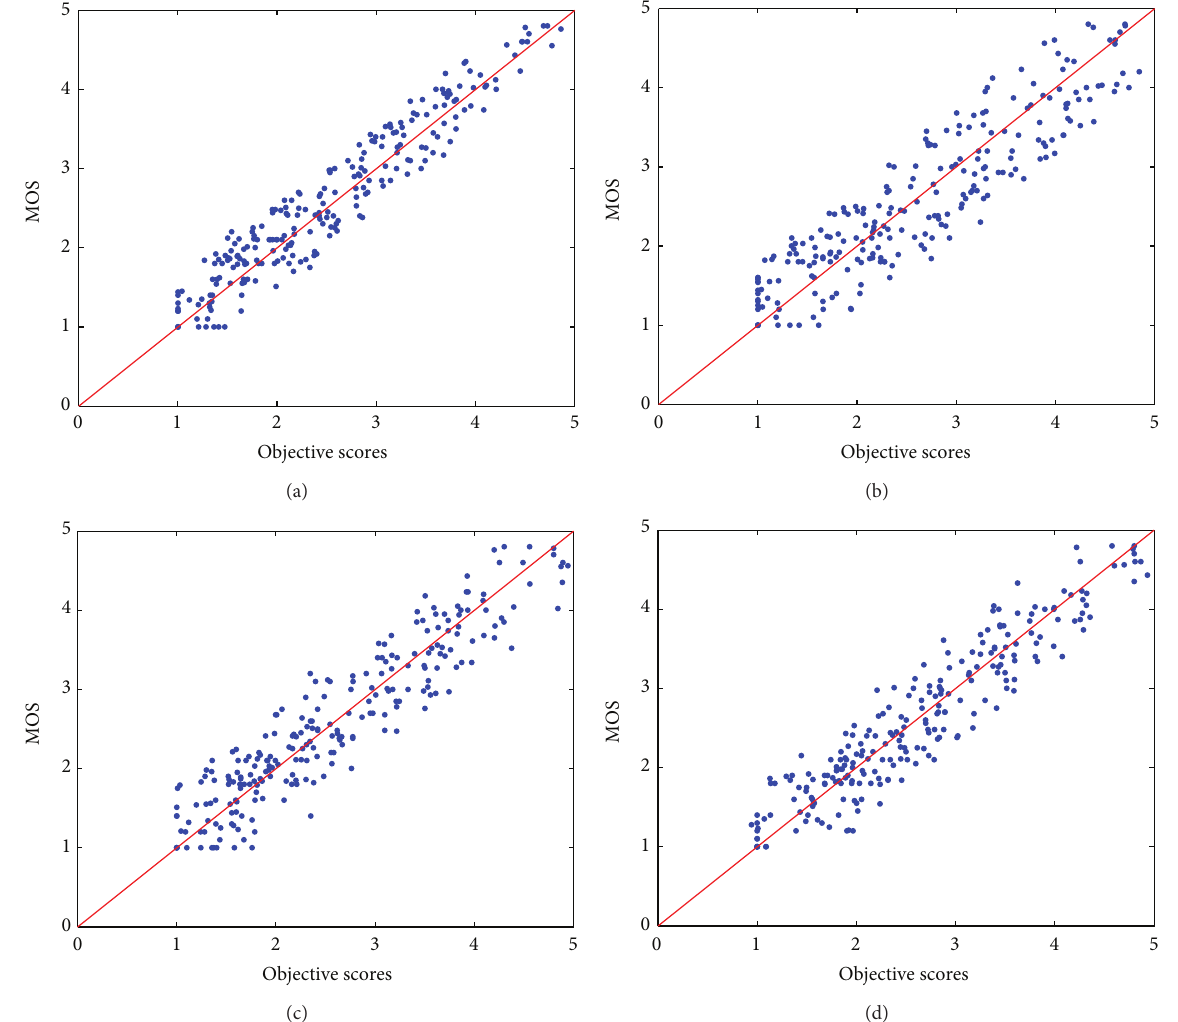
Figure 11: Scatter plots of the MOS versus the objective scores. (a) Proposed model, (b) P.1201.1 model, (c) NR QANV-PA model, and (d) baseline